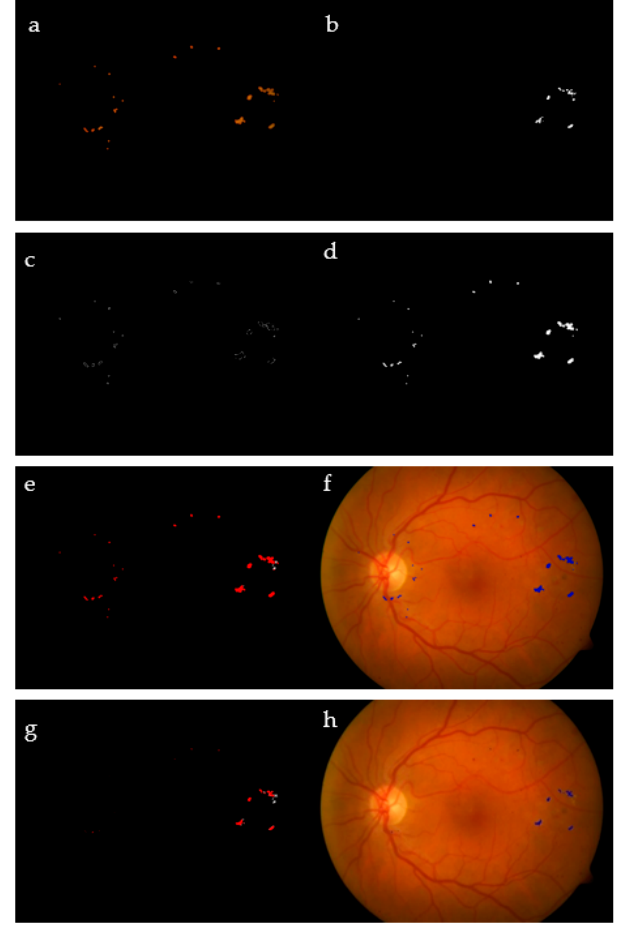
Figure 14. FCM clustering: RGB expected exudates ( a ); GT ( b ); clusters C 1 ( c ) and C 2 ( d ); red represents extracted exudates, while white pixels refer to the GT ( e ); superimposed results on the original image ( f ); extracted exudates after morphological processing ( g ); superimposed results after mathematical morphology ( h